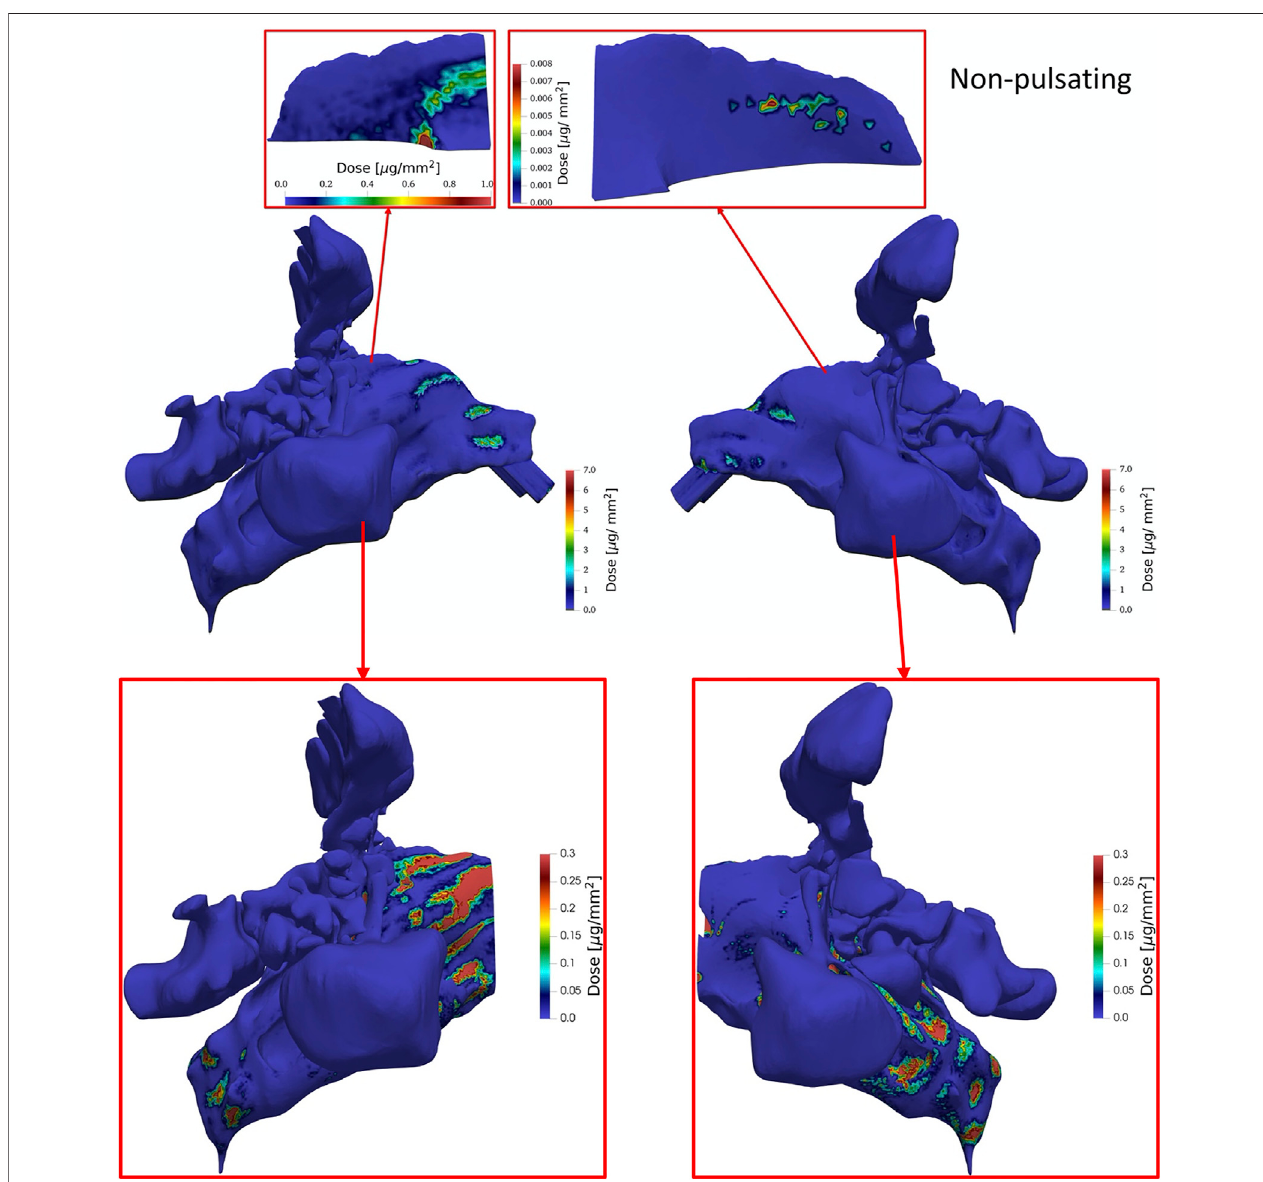
FIGURE 11 | The contour plots of tissue-delivered particle dose (of 1 µm particles) presented as mass of particles per surface area tissue at t (cid:2) 1.98 s (end of inhalation)in theentirenasal airwayfromright and leftviews (middle) aswellasareduced section ofthe nasal airwaywithoutthehigh dosesection inthe anterior partof the nasal cavity (bottom) and a close-up view of right and left olfactory regions (top) for non-pulsatile aerosol delivery with an aerosol concentration of 75 g/m 3 (particle density assumed 1 kg/m 3 ; water), constant fl ow rate of 4 L/min and a total inhaled dose of 2.5 mg.